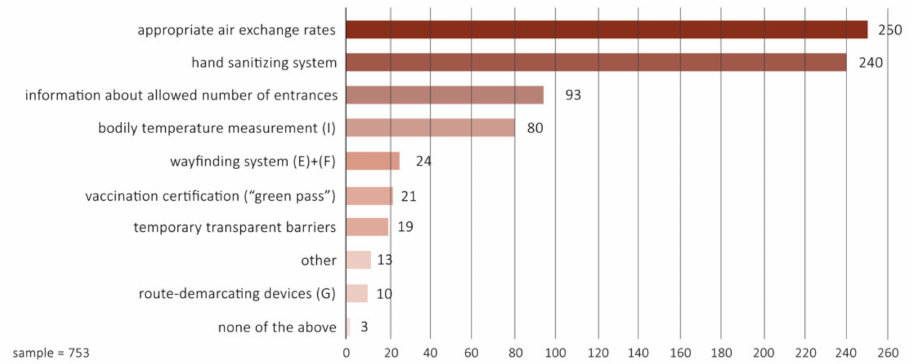
Figure 11. Graphics illustrating the users’ opinions about the most important elements from a safety perspective (case studies survey research). Own processing.